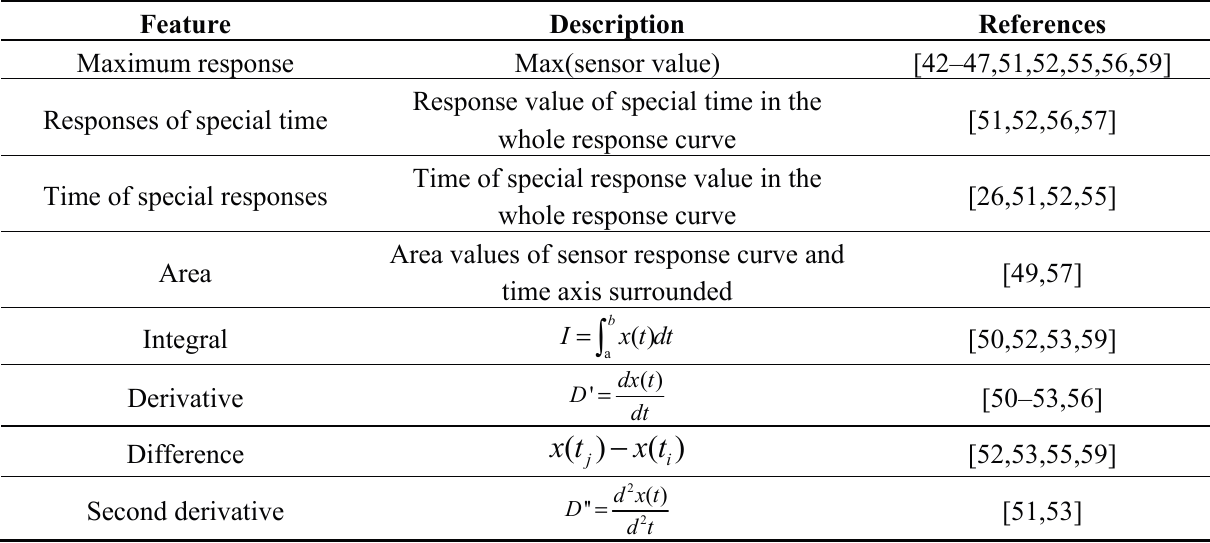
Table 5. Summary of commonly used features extracted from original response